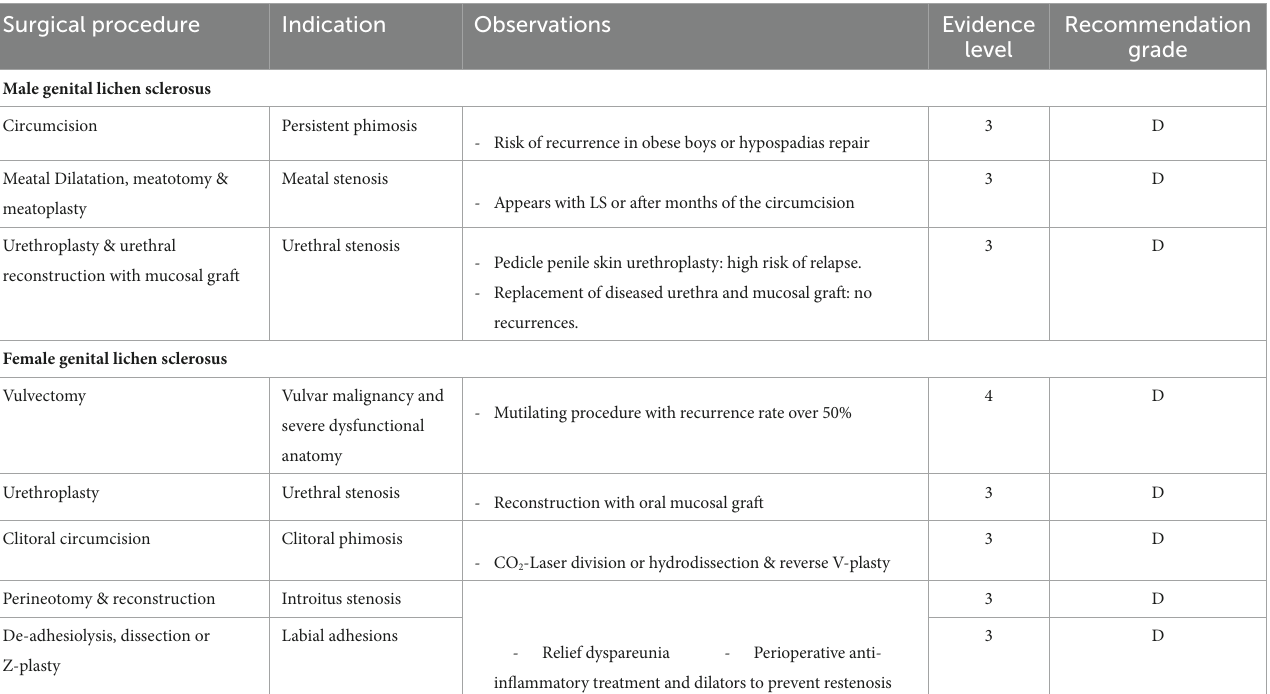
TABLE 10 Summary of surgical treatments in genital lichen sclerosus (9,